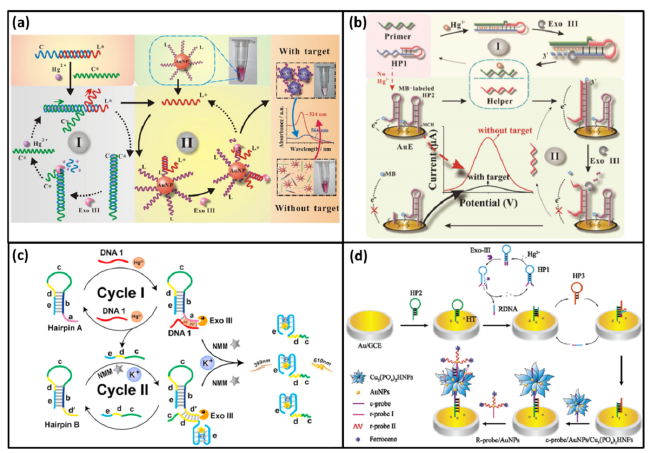
Figure 3. ( a ) A scheme of a colorimetric DNA biosensor for visual detection Hg 2+ based on Exo III- driven twice cycles signal amplification strategy and AuNPs. Reprinted with permission